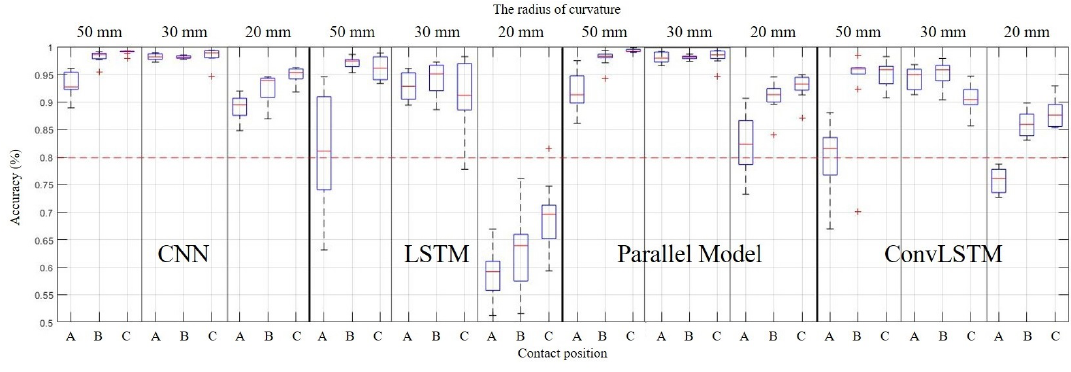
Figure 12. Result